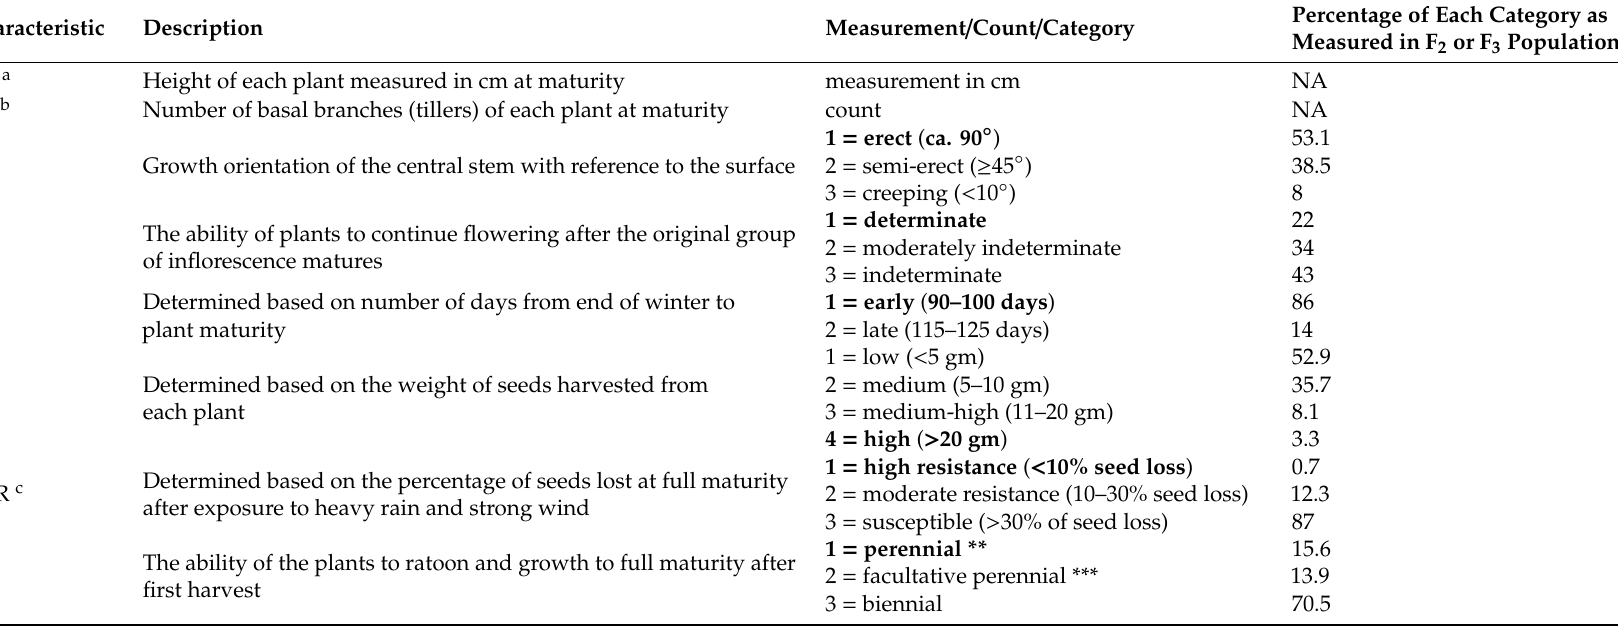
Table 1. Description of characteristics analyzed in this study: (1) plant height (PH), number of stems per plant (NS), and stem growth orientation (SO) were determined for the 375 individual plants of the F 2 population grown in the greenhouse; (2) flowering habit (FH), earliness (ER), seed yield per plant (SY), pod shattering resistance (SHR), and perenniality (PE) were determined for the 2250 individual plants of the F 3 population grown at two field sites (1125 plants at each site). The percentages of each category measured at F 2 or F 3 stages is given in the fourth column for the categorical characteristics. Desirable characters of the characteristics for field cress domestication are shown in